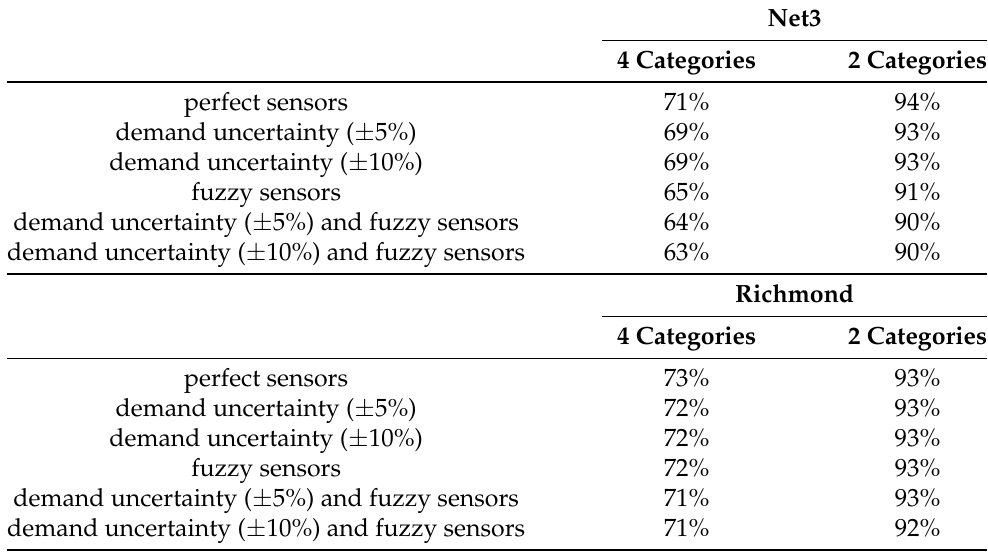
Table 6. Influence of demand uncertainty and fuzzy sensors for Net3 and Richmond network on prediction model